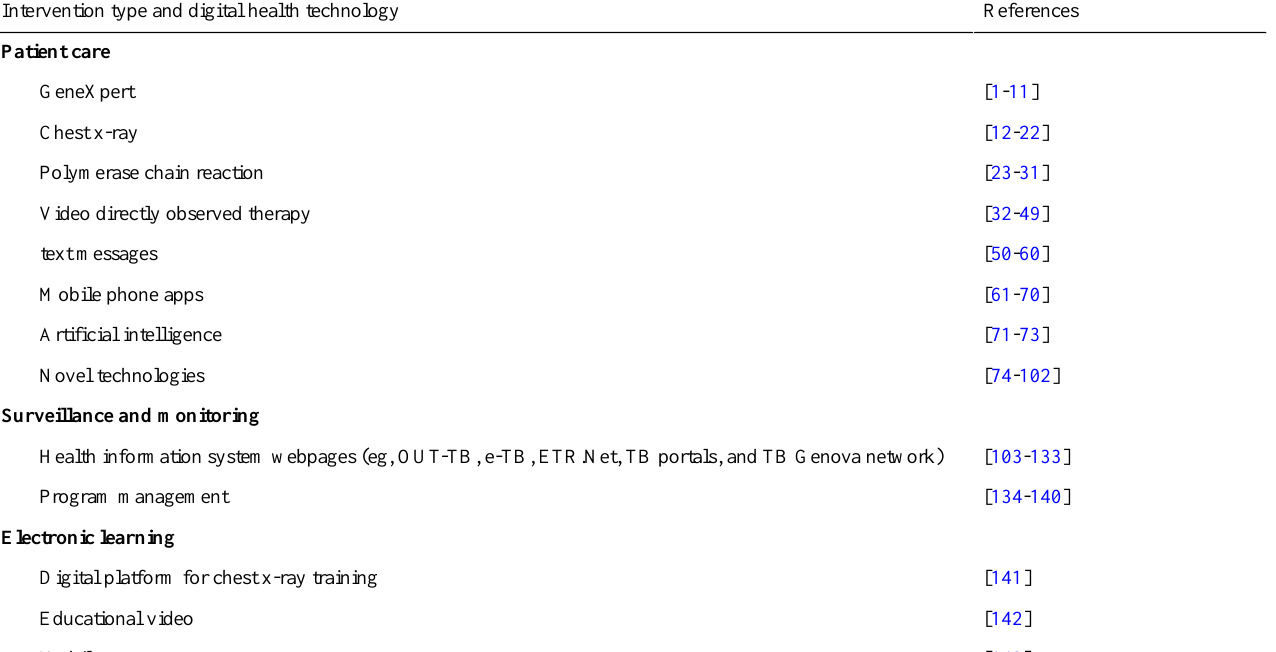
Table 1. Four types of